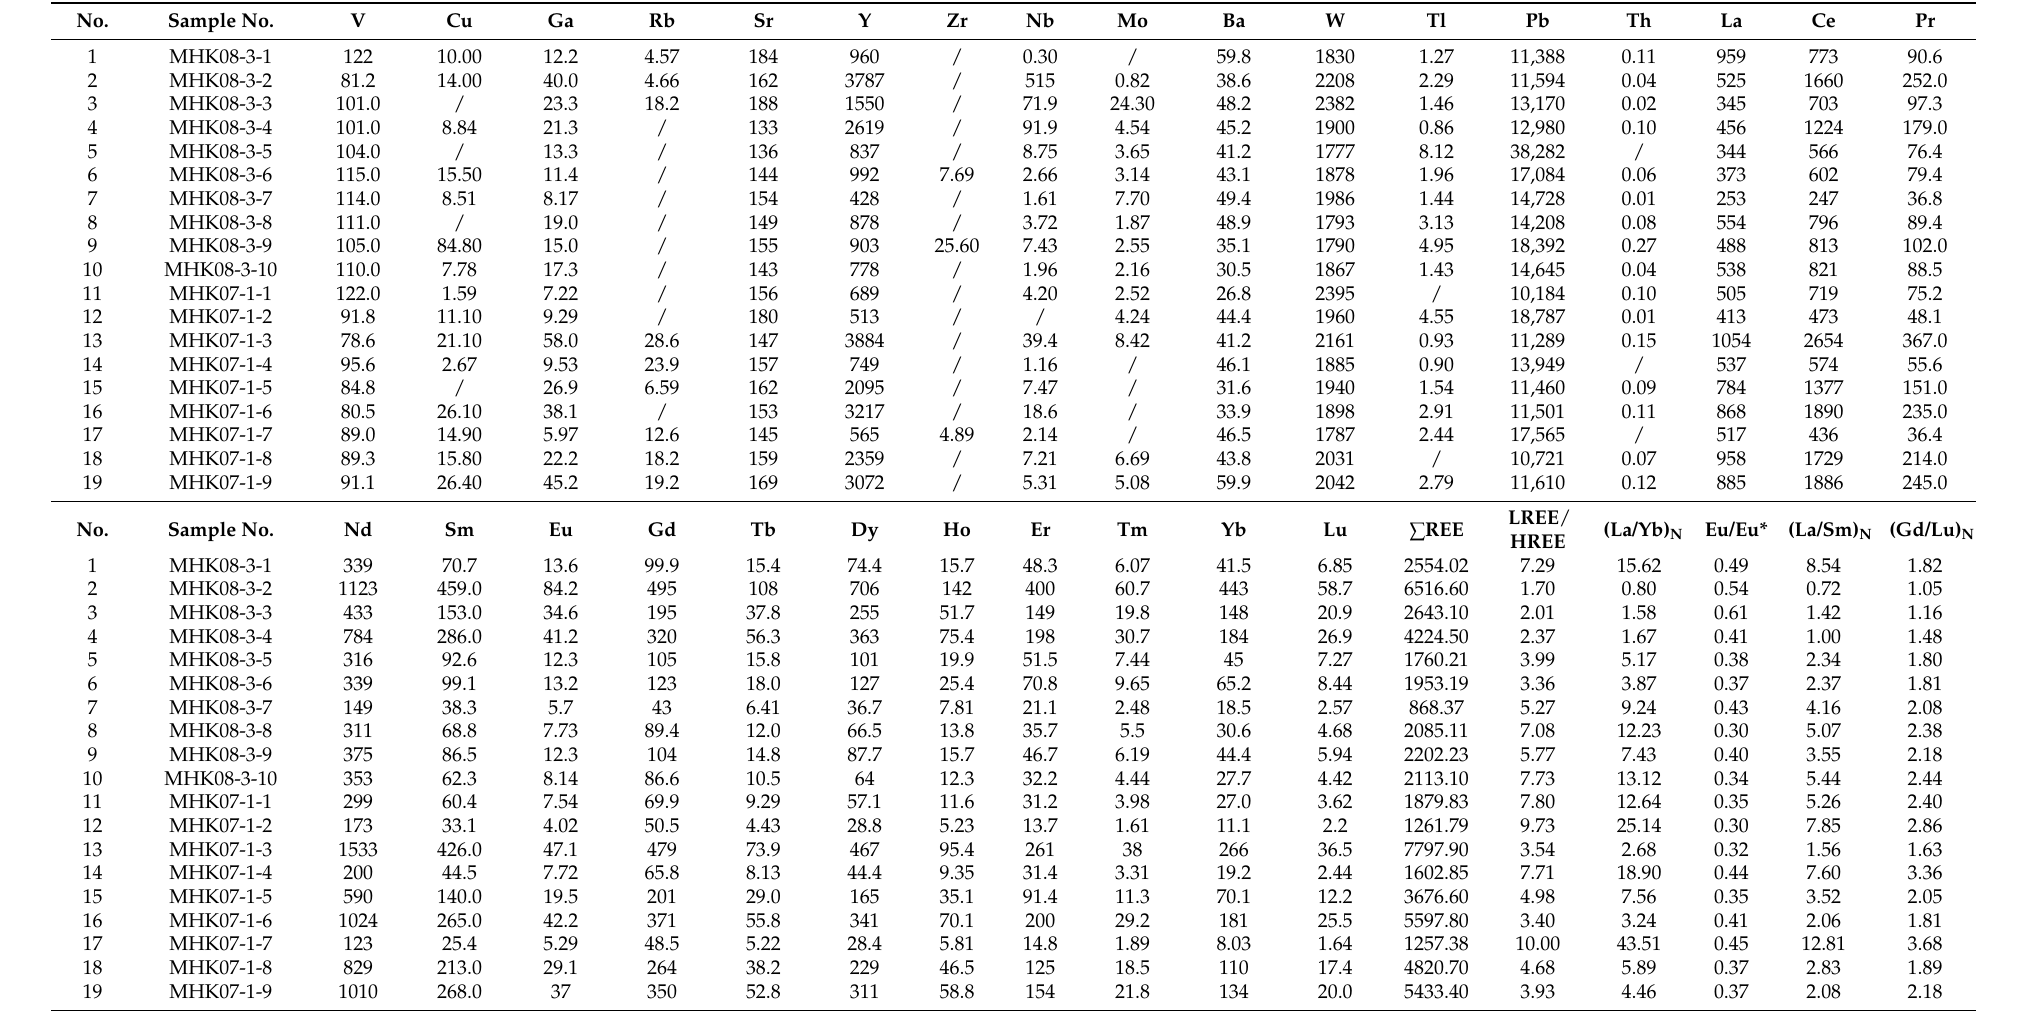
Table 5. The LA-ICPMS analyses of trace element and REE concentrations (ppm) for pitchblende. “/” means “below detection limit”. No. Sample